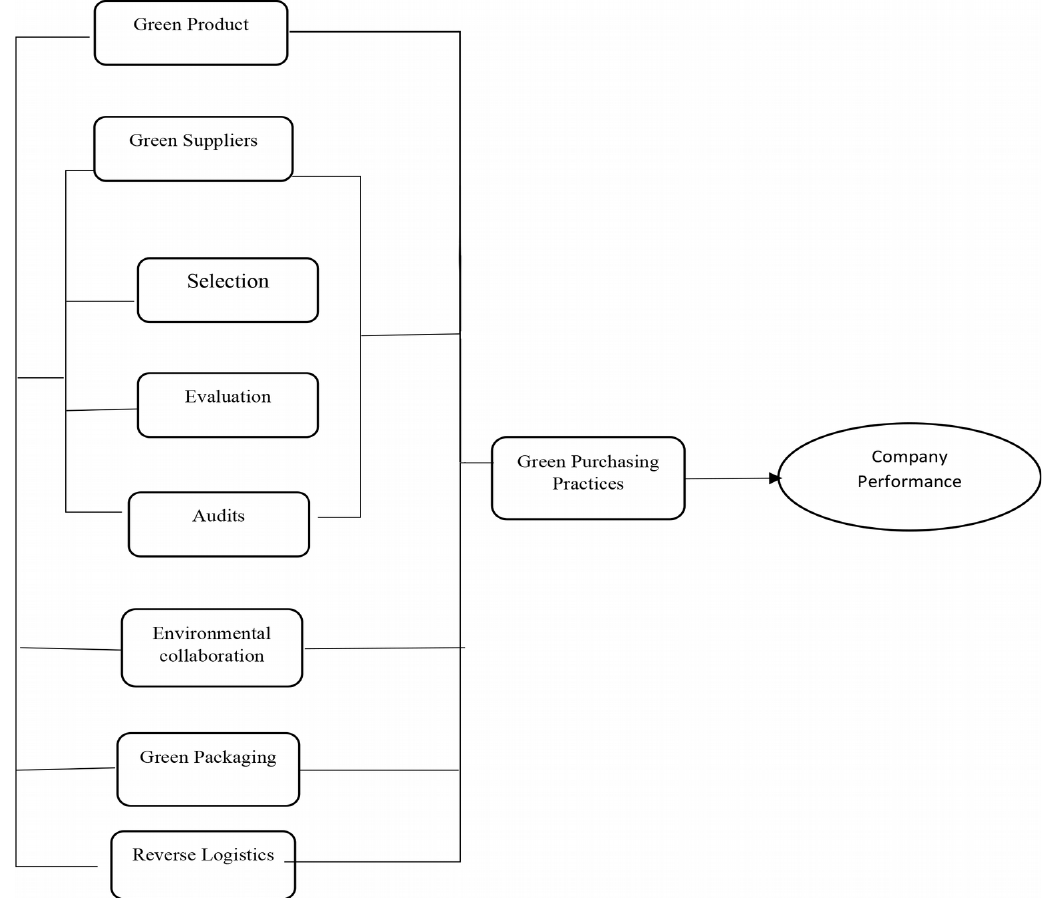
Figure 1. Proposed